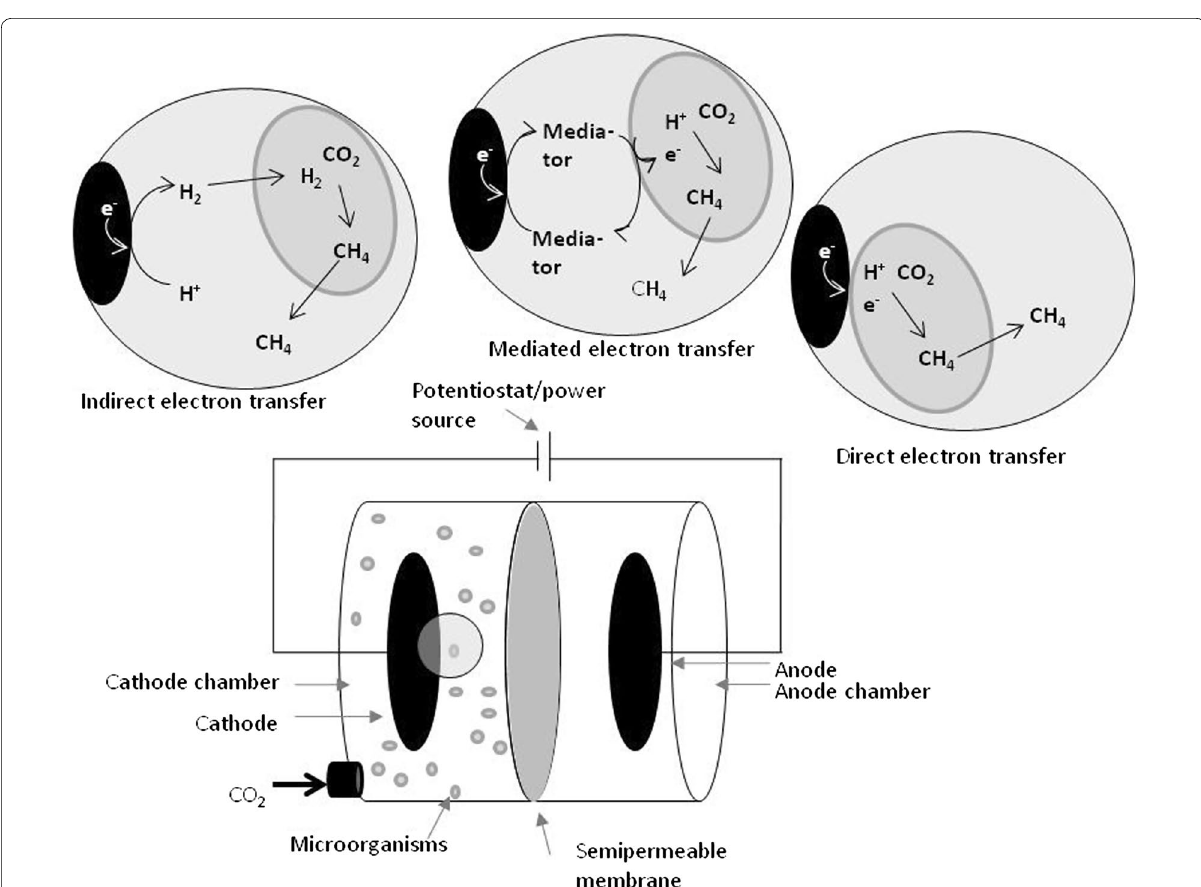
Fig. 2 Extracellular electron transfer. Means of electron transfer within a separated, electromethanogenic system at the cathode: indirect electron transfer (IET), mediated electron transfer (MET) and direct electron transfer